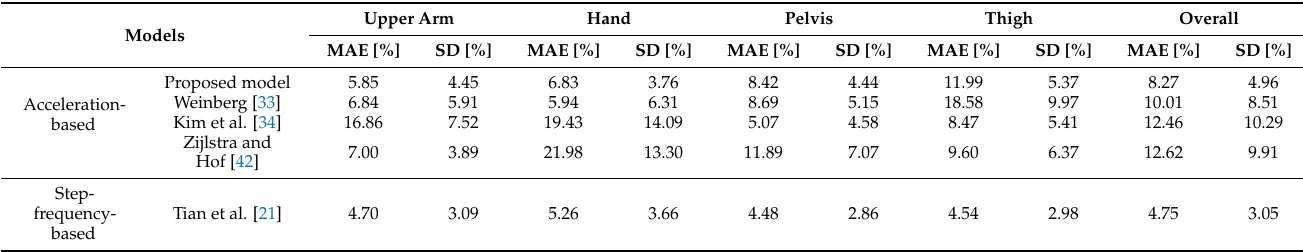
Table 3. MAEs and SDs of walked distances estimated by the selected models for smartphones attached to the upper arm, hand, pelvis, and thigh.